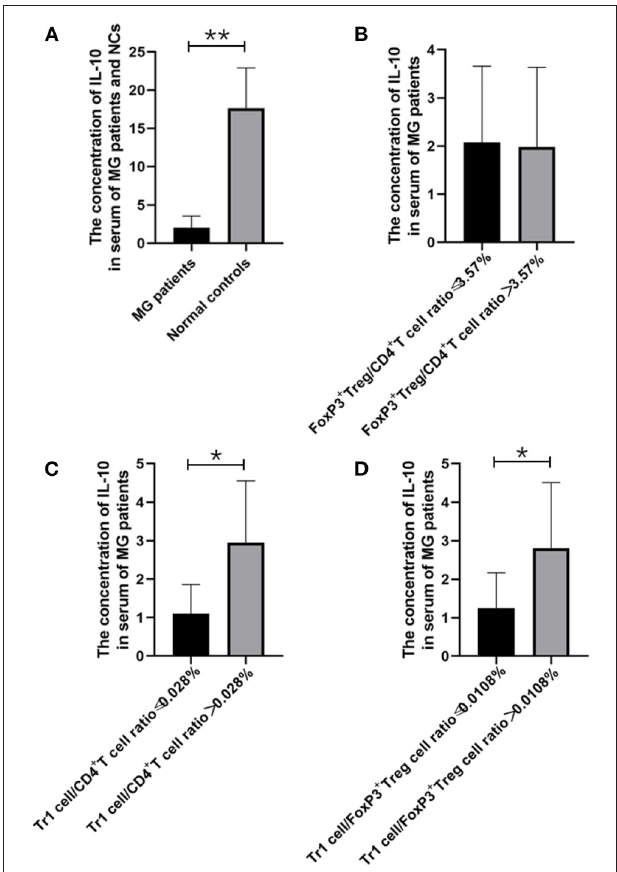
FIGURE 2 | The relationship between IL-10 concentration and MG onsets, FoxP3 + Treg/CD4 + T ratio, Tr1/CD4 + T cells ratio and Tr1/FoxP3 + Tregs ratio. (A) , IL-10 concentration in the serum of MG patients was found significantly lower than the concentration of IL-10 in the NCs ( p = 0.005). (B–D) , higher Tr1/CD4 + T cells ratio and Tr1/FoxP3 + Tregs ratio were usually accompanied by higher IL-10 concentration, and a significant positive correlation was found between Tr1/ CD4 + T ratio and IL-10 ( p = 0.048), Furthermore, Tr1/FoxP3 + Tregs cell ratio was found positively correlated with IL-10 ( p = 0.048). The data were shown as mean with ± SD of each group, *means p < 0.05, **means p < 0.01. N = 10 for MG group and N = 8 for NC